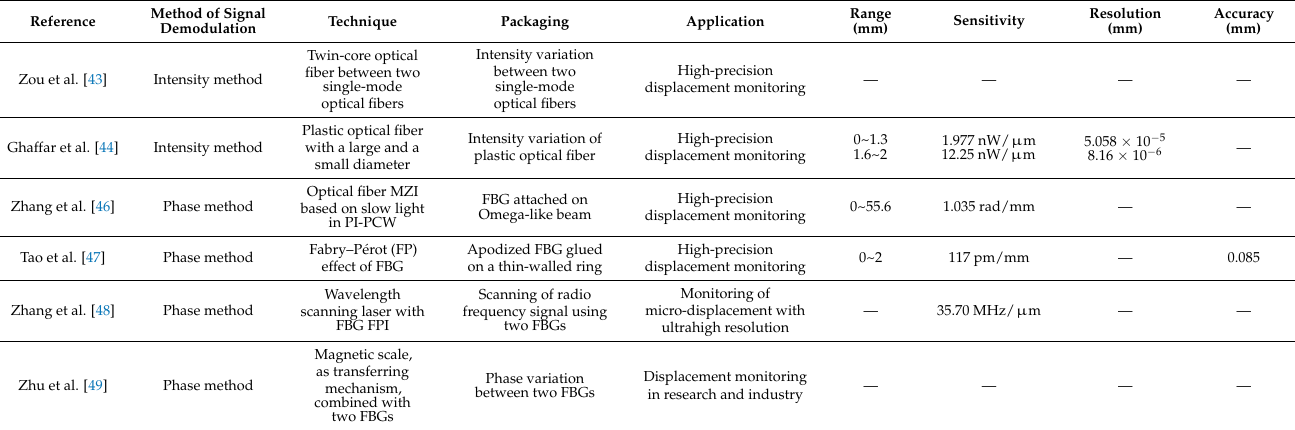
Table 2. Applications and performances for FBG-based displacement sensors according to optical intensity and phase signal demodulation (Section